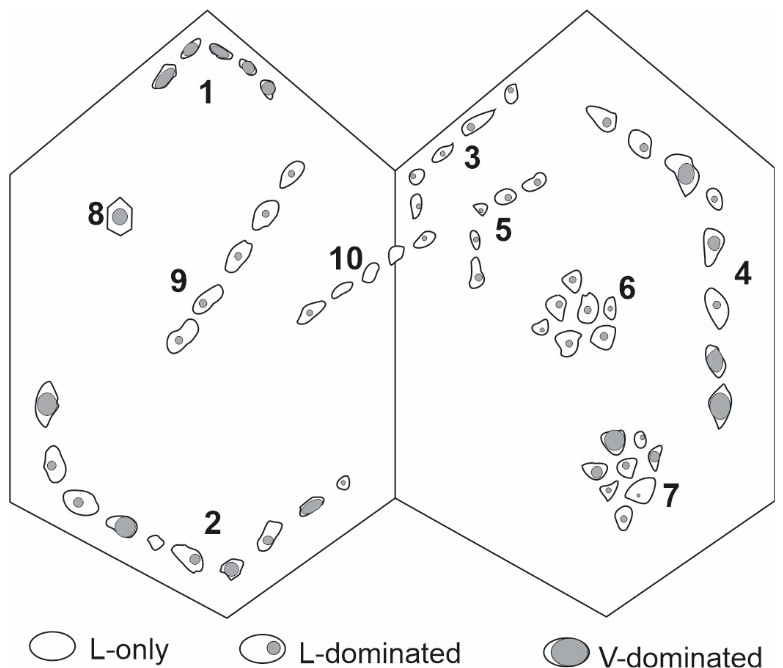
Figure 3. A schematic example of various modes of occurrence of fluid inclusions with an emphasis on fluid inclusion assemblages (FIAs). See text for detailed discussion.